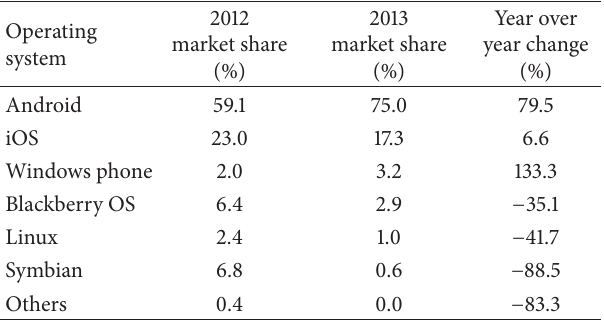
Table 1: Market share among Smartphone OS-IDC worldwide quarterly mobile phone tracker, May 2013.